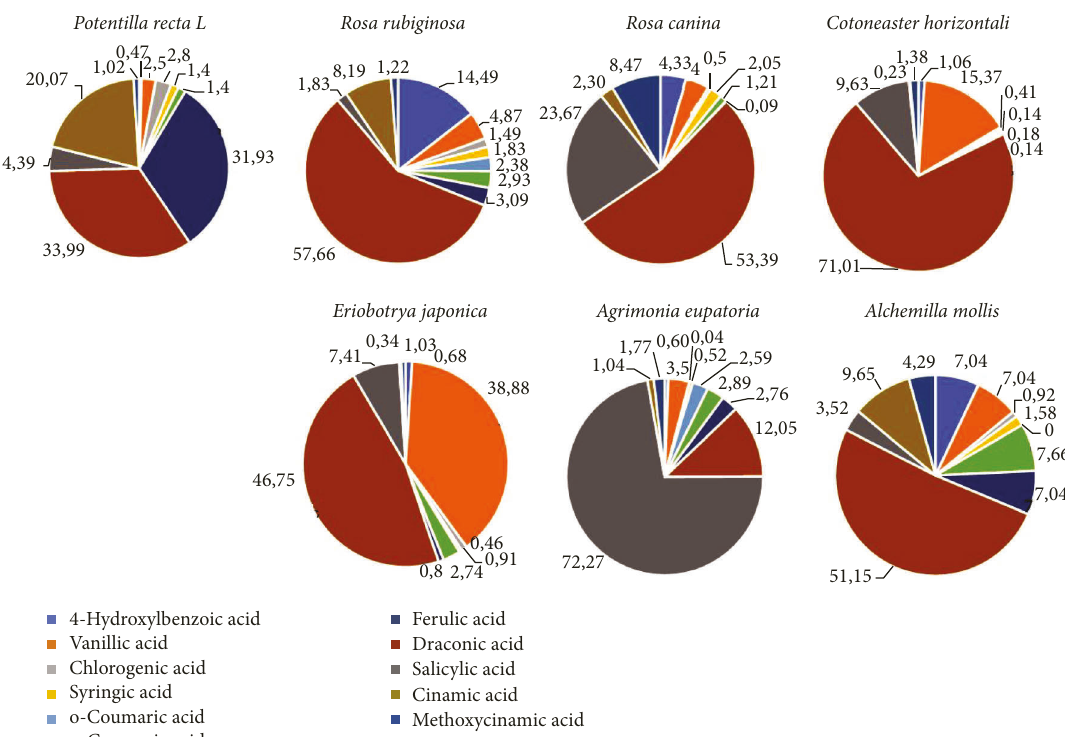
Figure 4: Percentage of phenolic acids amounts in the methanolic extract of representatives of the family Rosaceae